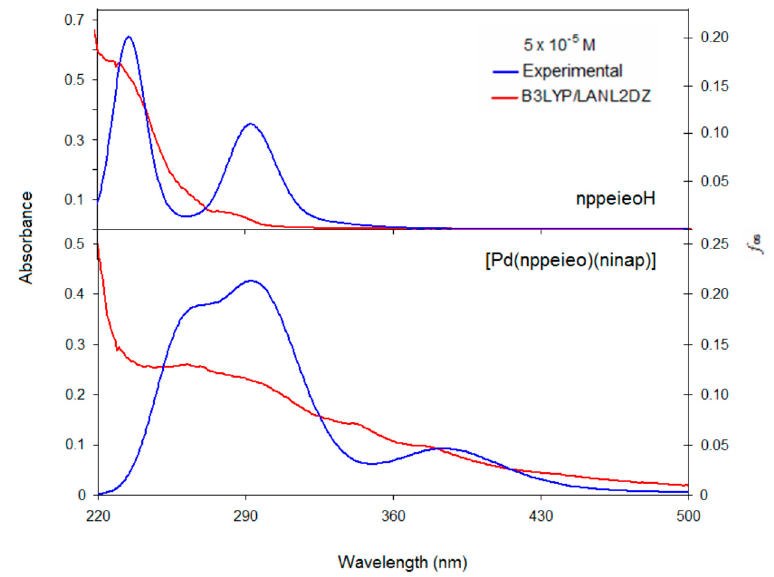
Figure 9. Experimental and calculated electronic spectra of nppeieoH and its palladium(II) complex. Table 4. Experimental and calculated electronic transitions, oscillator strengths and their assignments for nppeieoH and [Pd(nppeieo)(ninap)] a .